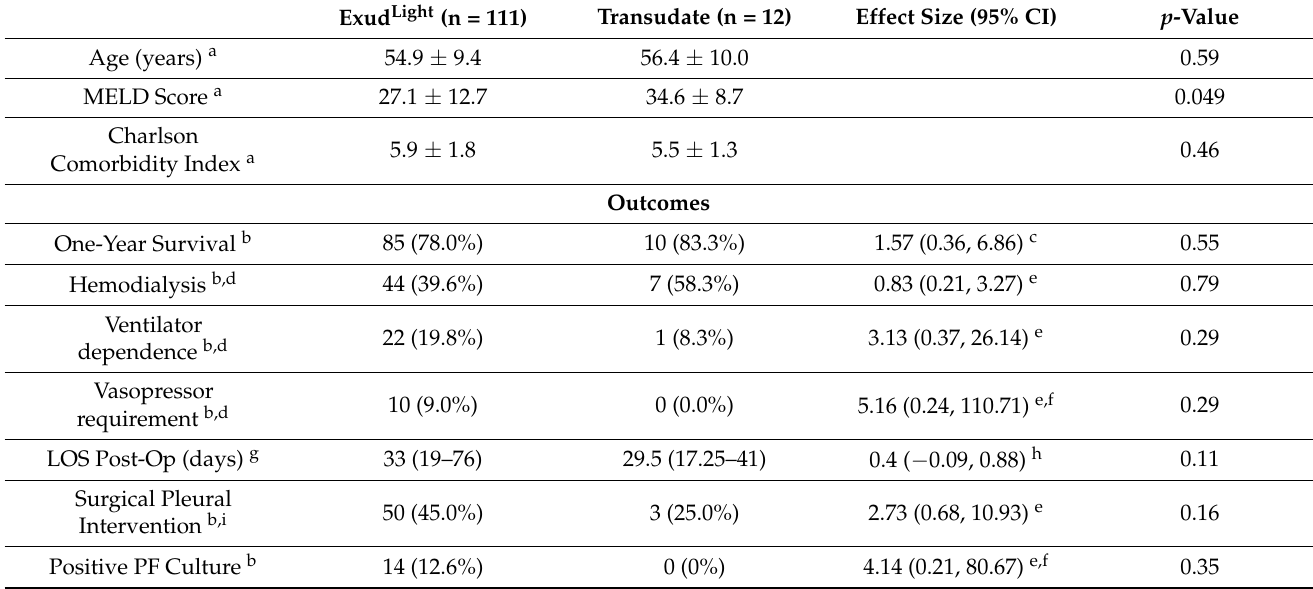
Table 2. Clinical outcomes for post-OLT exudates by Light’s criteria (Exud Light ) vs.